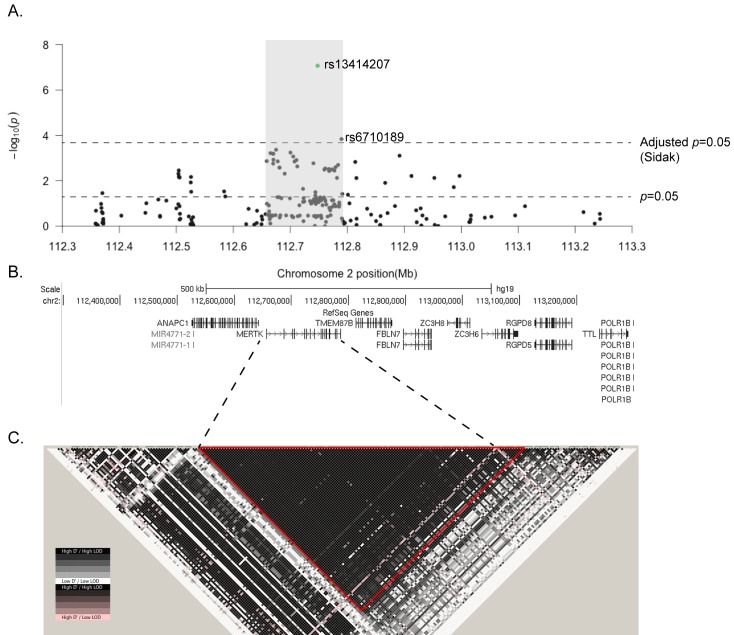
A low-frequency SNP within MERTK is significantly associated with MS susceptibility.124 SNPs on chromosome 2 were directly genotyped in 3268 MS cases and 3579 controls. (A) The negative log of the unadjusted p-value of each SNP is plotted against the relative position on chromosome 2, with a schematic of the gene structures shown underneath (B). Two SNPs, both within MERTK, reach significance using the Sidak adjustment for multiple testing at a nominal α = 0.05. Association p-values were determined using a Chi-square test. (C) Schematic of the pattern of LD across the whole region, with a large single block of high LD (D'>0.99), including the whole of the MERTK gene, highlighted with a red triangle.